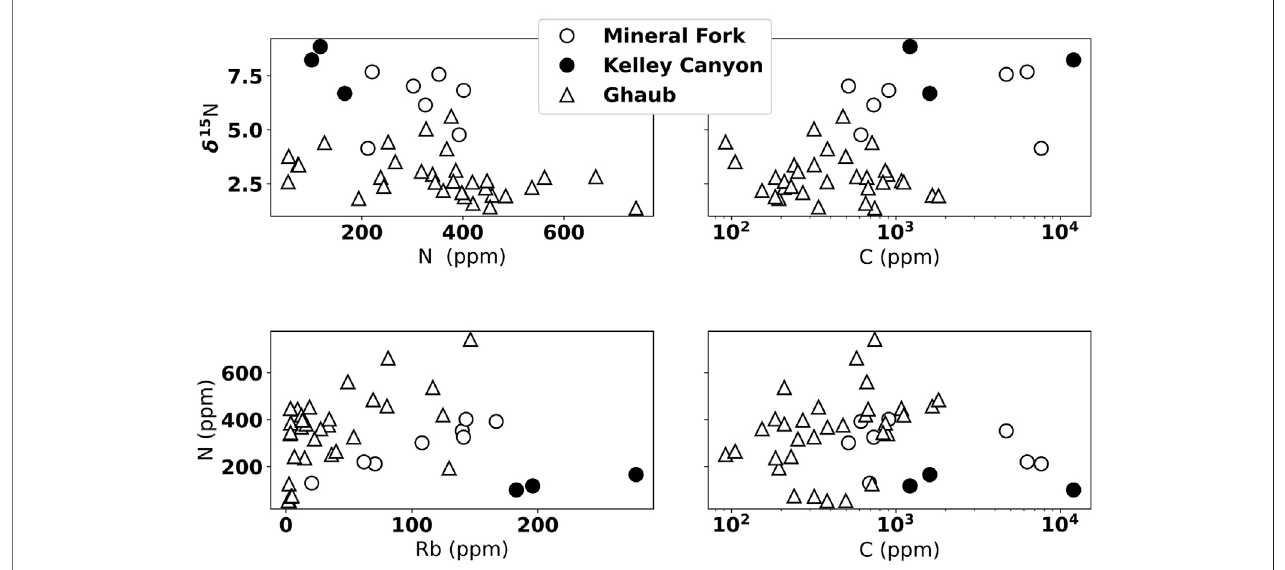
FIGURE 6 | Nitrogen isotope and concentration data shown in comparison to C and Rb concentration. We note no clear correlation between δ 15 N and N or C, indicating no signi fi cant N loss due to metamorphism or fl uid loss. Slight correlation between N and Rb concentration indicates there is some mineralogic control on the amount of N, but this is not in fl uencing the δ 15 N.